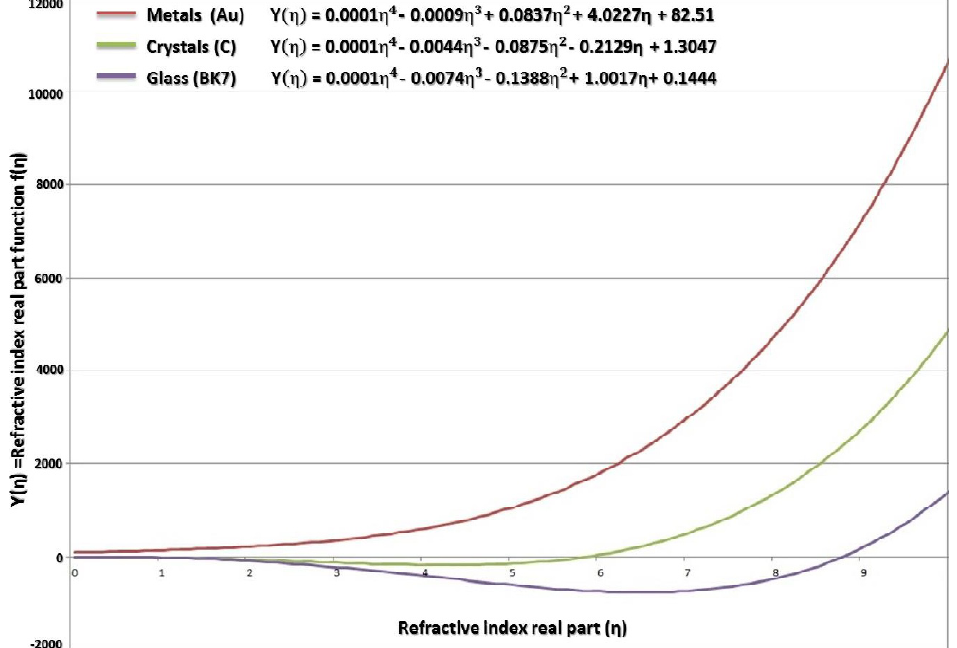
Fig. 7. Graph showing reference refractive index real part in materials for glass, crystals, and metals versus refractive index real part